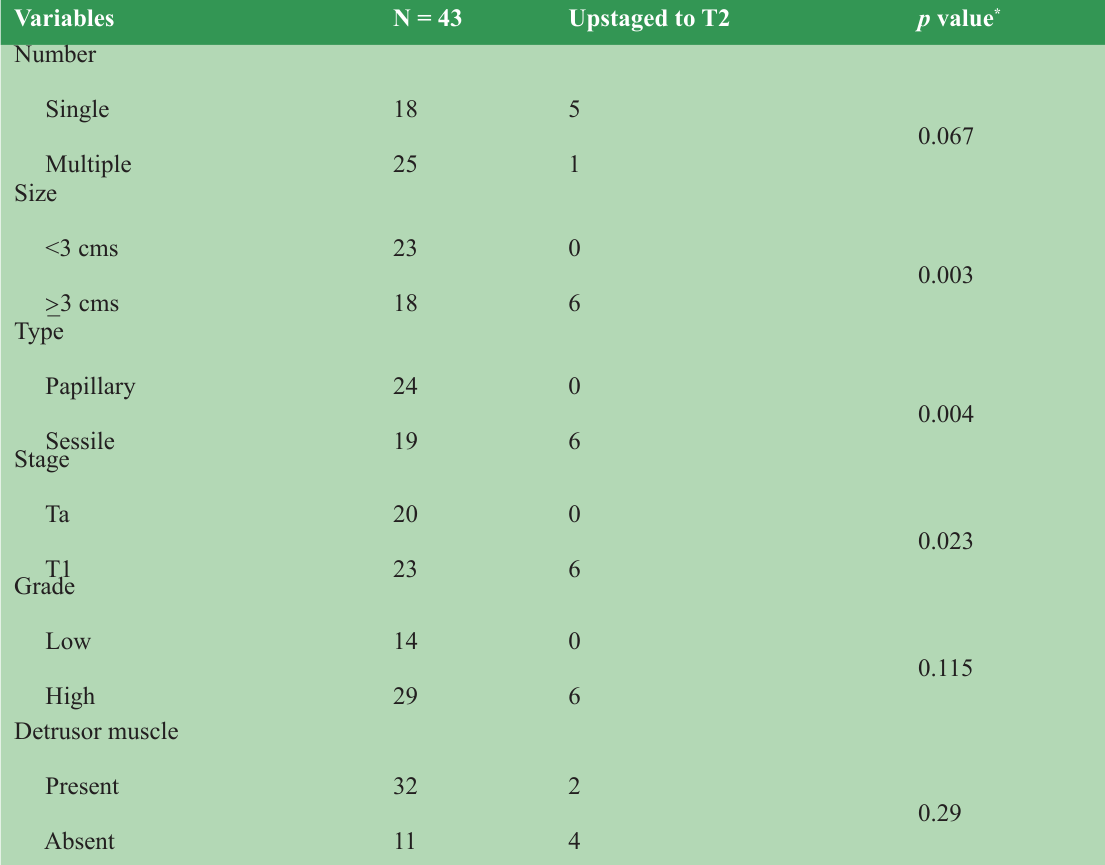
Table 3: Association between primary tumor characteristics and upstaging